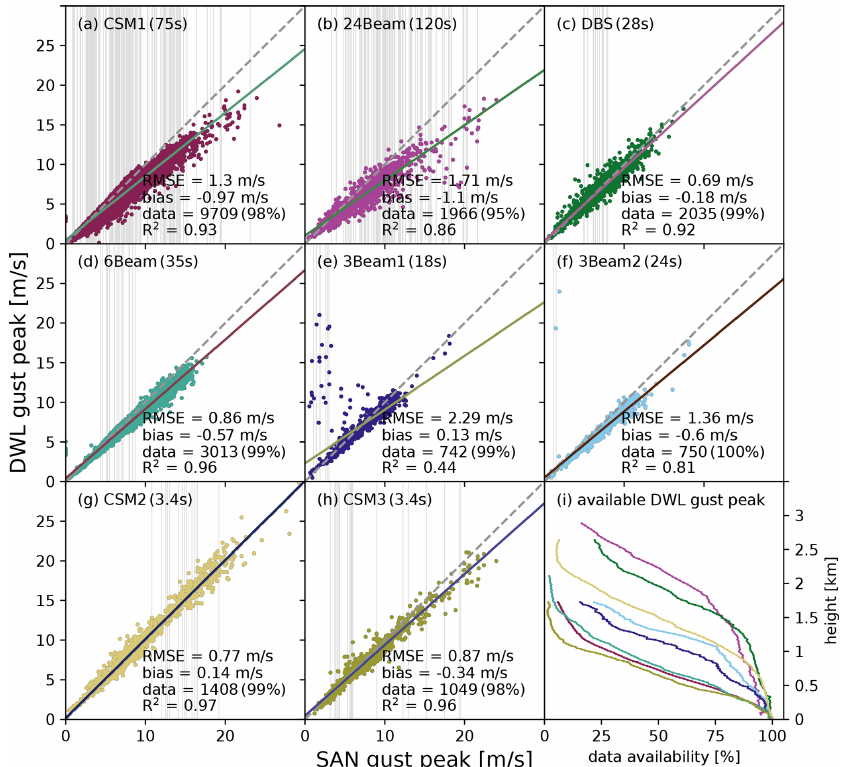
Figure 8. Scatterplots of the sonic anemometer (SAN) gust peak (3s in 10min) versus the DWL gust peak (gust duration as indicated per panel in 10min) for the eight different tested DWL configurations at 90.3m. The further explanations are the same as in Fig. 7. Panel (i) shows the data availability against height with colors per configuration as in panels (a) – (h)